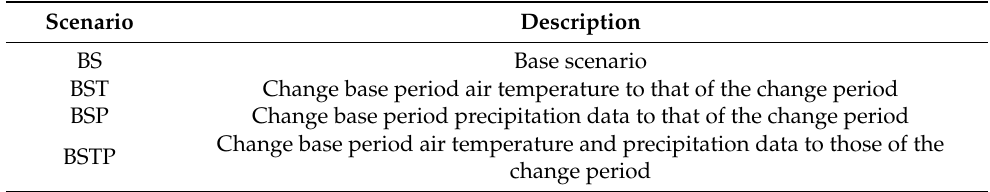
Table 5. Scenario settings for multifactor attribution